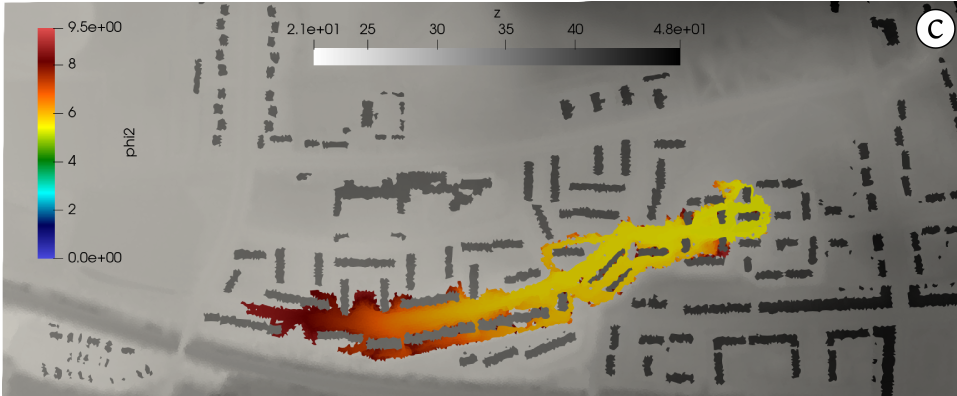
Figure 5. Case 1: Water ( a ) and pollutants ( b , c ) flood extent at t = 1.8 h.